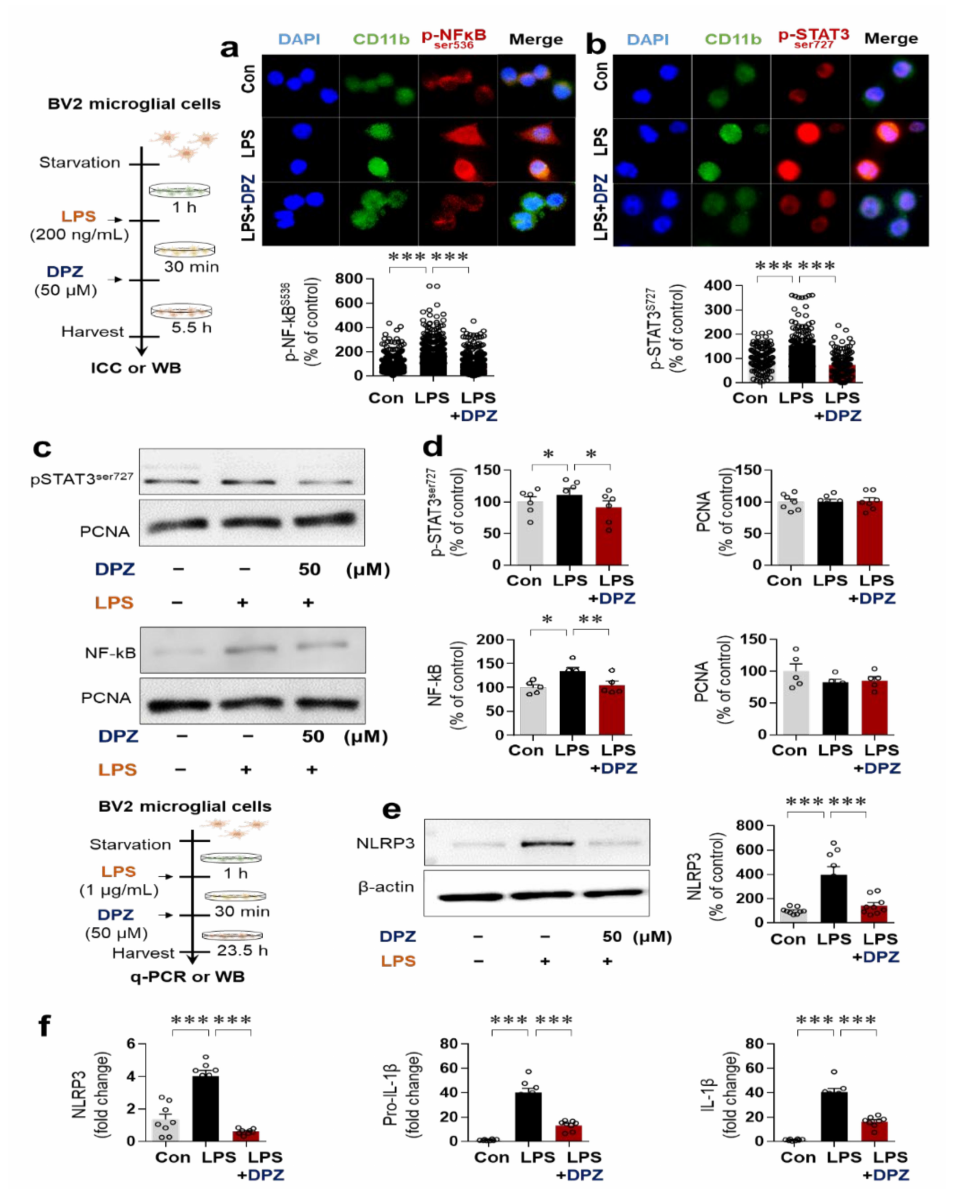
Figure 4. Donepezil regulates LPS-induced NF- κ B/STAT3 phosphorylation and NLRP3 inflammasome formation in BV2 microglial cells. ( a , b ) p-NF κ B Ser536 , p-STAT3 Ser727 , and CD11b expression, as determined by ICC analysis (p-NF-kB ser536 : Con: n = 353, LPS: n = 331, LPS + Donepezil: n = 339; p-STAT3 ser727 : Con: n = 133, LPS: n = 148, LPS + Donepezil: n = 138). ( c , d ) Nuclear fractionation analysis of p-STAT3, NF-kB, and PCNA in cells pretreated with 200 ng/mL LPS or PBS for 30 min and treated with 50 µ M donepezil or vehicle (1% DMSO) for 5.5 h, as determined by Western blot ( n = 6–7/group). I NLRP3 protein expression levels in cells pretreated with 1 µ g/mL LPS or PBS for 30 min and treated with 50 µ M donepezil or vehicle (1% DMSO) for 23.5 h, as determined by Western blot ( n = 9/group). ( f ) NLRP3 inflammasome formation in cells pretreated with 1 µ g/mL LPS or PBS for 30 min and treated with 50 µ M donepezil or vehicle (1% DMSO) for 23.5 h, as determined by q-PCR ( n = 8/group). * p < 0.05, ** p < 0.01, *** p <